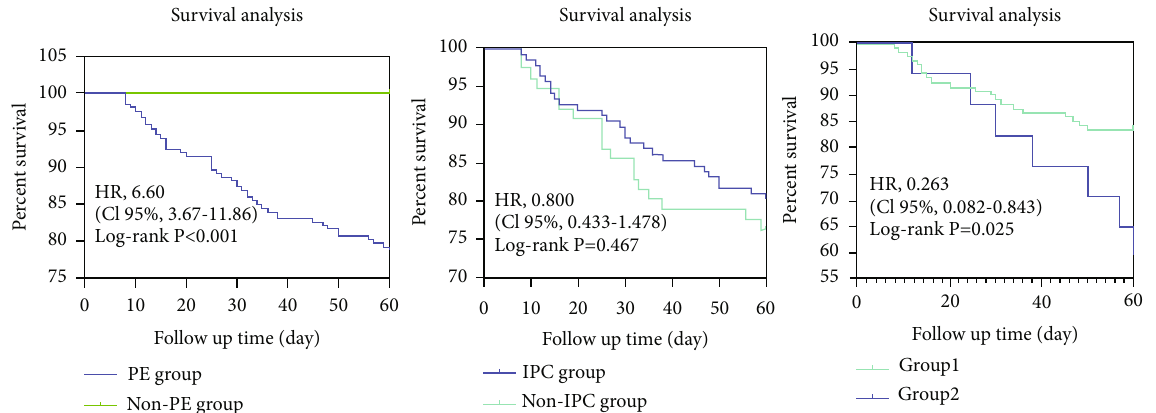
Figure 2: Kaplan-Meier percent survival curves of 60 days. PE: pleural e ff usion; IPC: indwelling pleural catheter. Group 1: IPC within 1 week after onset. Group 2: IPC after 1 week of